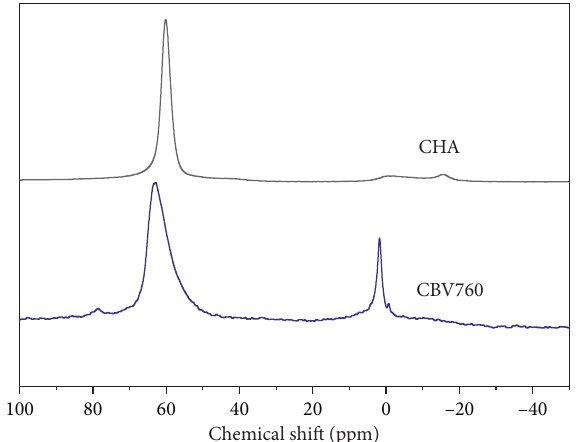
Figure 7: 27 Al MAS NMR of faujasite CBV760 and CHA sample